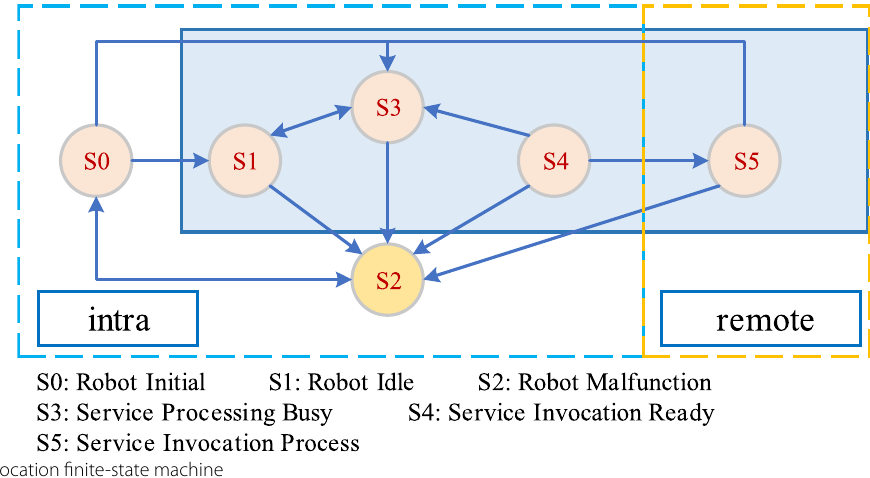
Fig. 2 Service invocation finite-state machine